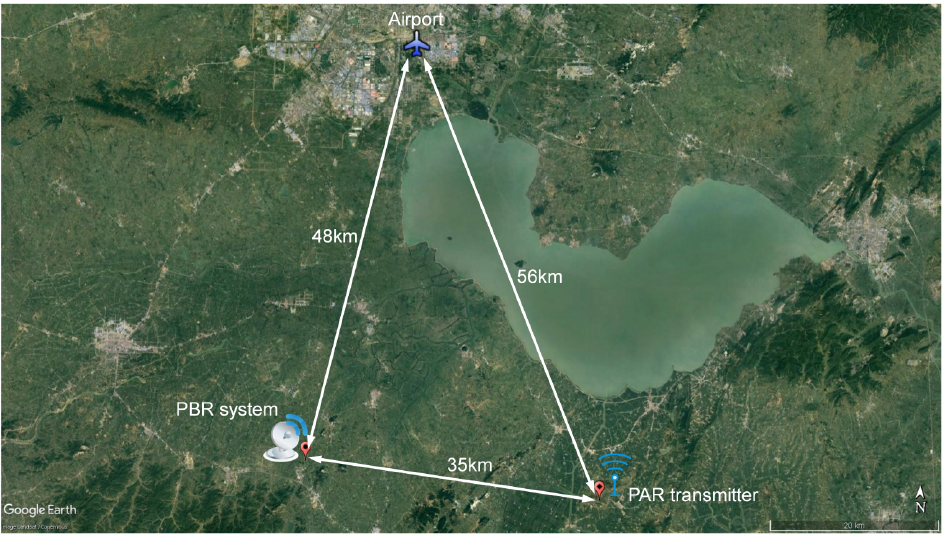
Figure 11. The experimental scenario geometry.